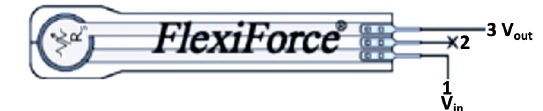
Figure 4. Conceptual Diagram of the problem and proposed socket interface pressure (SIFP) system shown in blue dashed line. It includes both the SIFP device and the motion capture (MOCAP) sub-system.